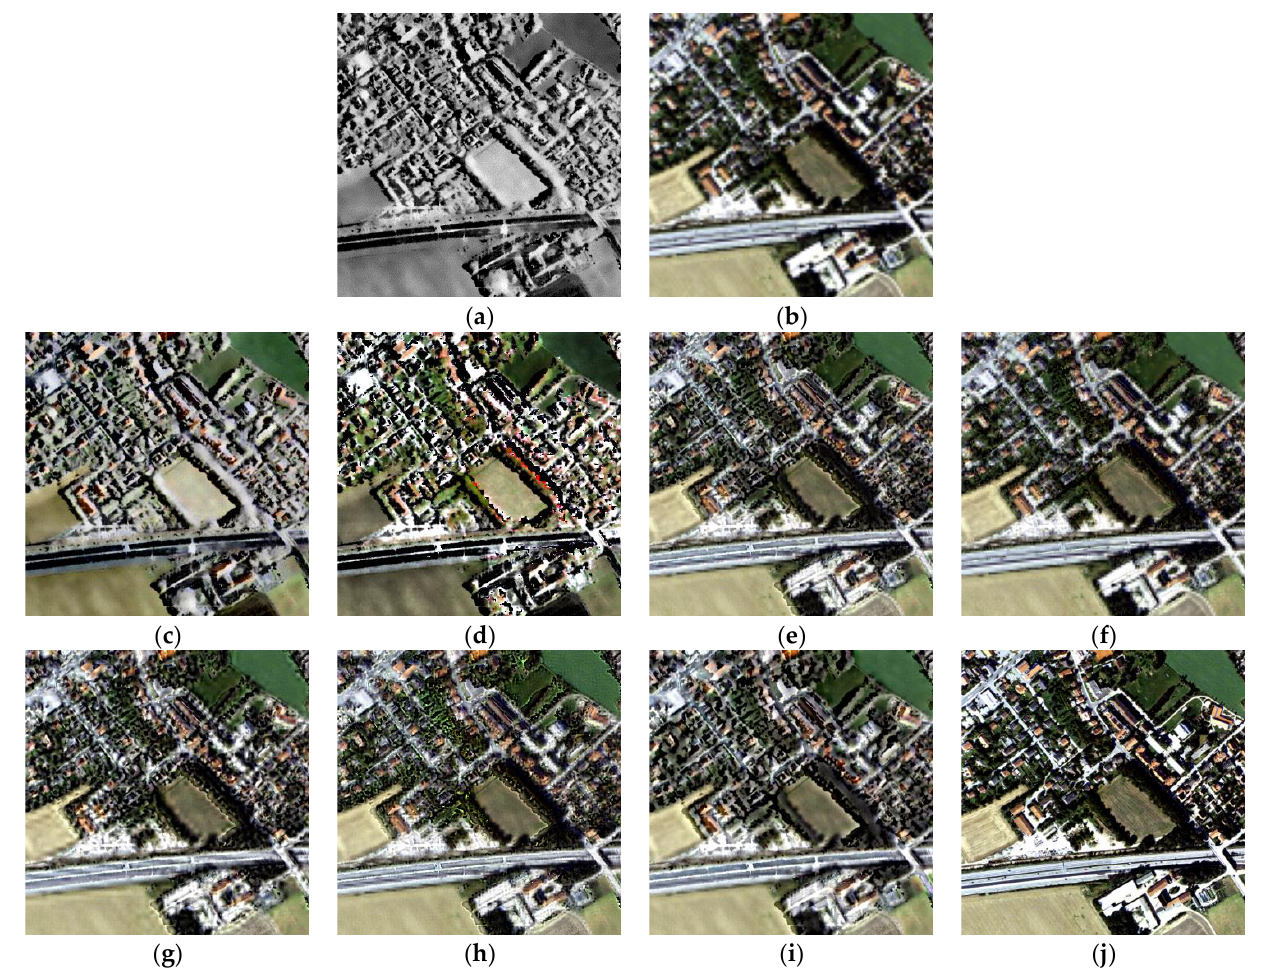
Figure 5. Fusion results of different methods in area 2. ( a ) HR SAR image; ( b ) up-sampled LR multispectral image; ( c ) IHS fusion; ( d ) BTH fusion; ( e ) LP-based fusion; ( f ) AWLPR fusion; ( g ) IW fusion; ( h ) GFTD fusion; ( i ) proposed LPSR fusion; ( j ) original HR multispectral image. Table 2. Quantitative evaluation results of different fusion methods in area